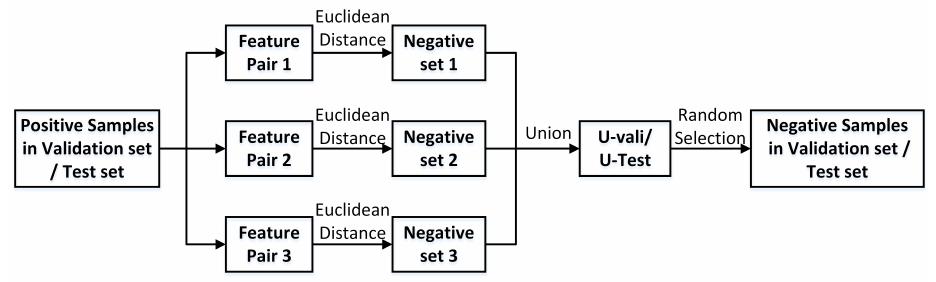
Figure 1. The negative sampling process of the validation set and test set.